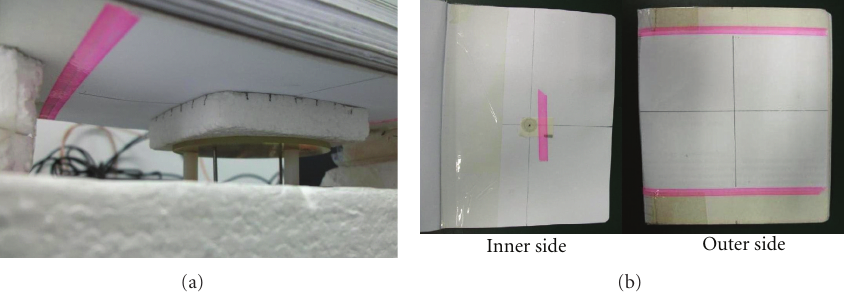
Figure 9: Measurement of interrogation range when real object equipped with NF tag: (a) book is located above antenna. (b) Inner and outer face of book cover, and intersection of the two lines on outer face is the center location of tag.